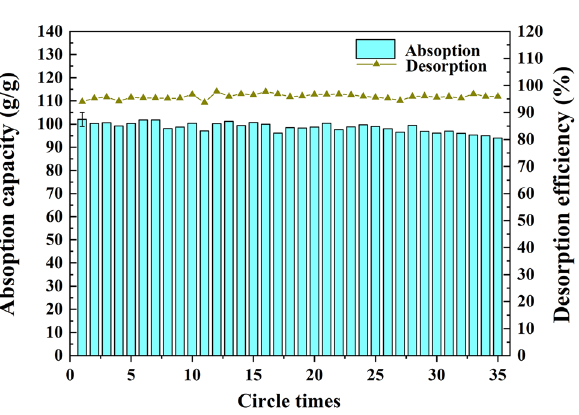
Figure 16. Absorption–desorption recyclability of OTS-PDA-MS for sunflower oils.